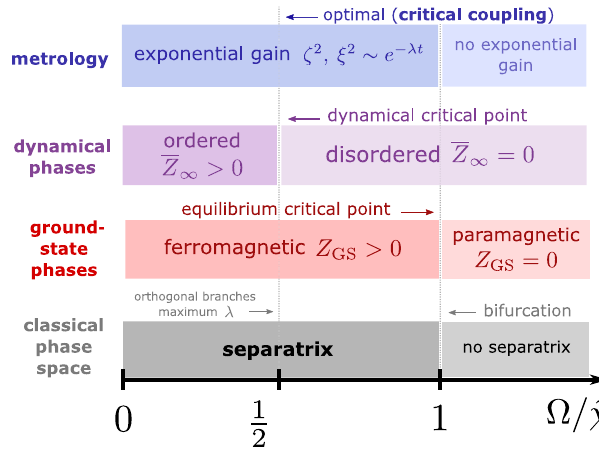
FIG. 4. Behavior of the ratio in Eq. (46) between the actual quantum speed of the initial state and the maximum possible one, as a function of ˜ χ/(cid:22) , for different values of the squeez- ing r . Note how the quantum speed limit is saturated at critical coupling, independently of the amount of squeezing.